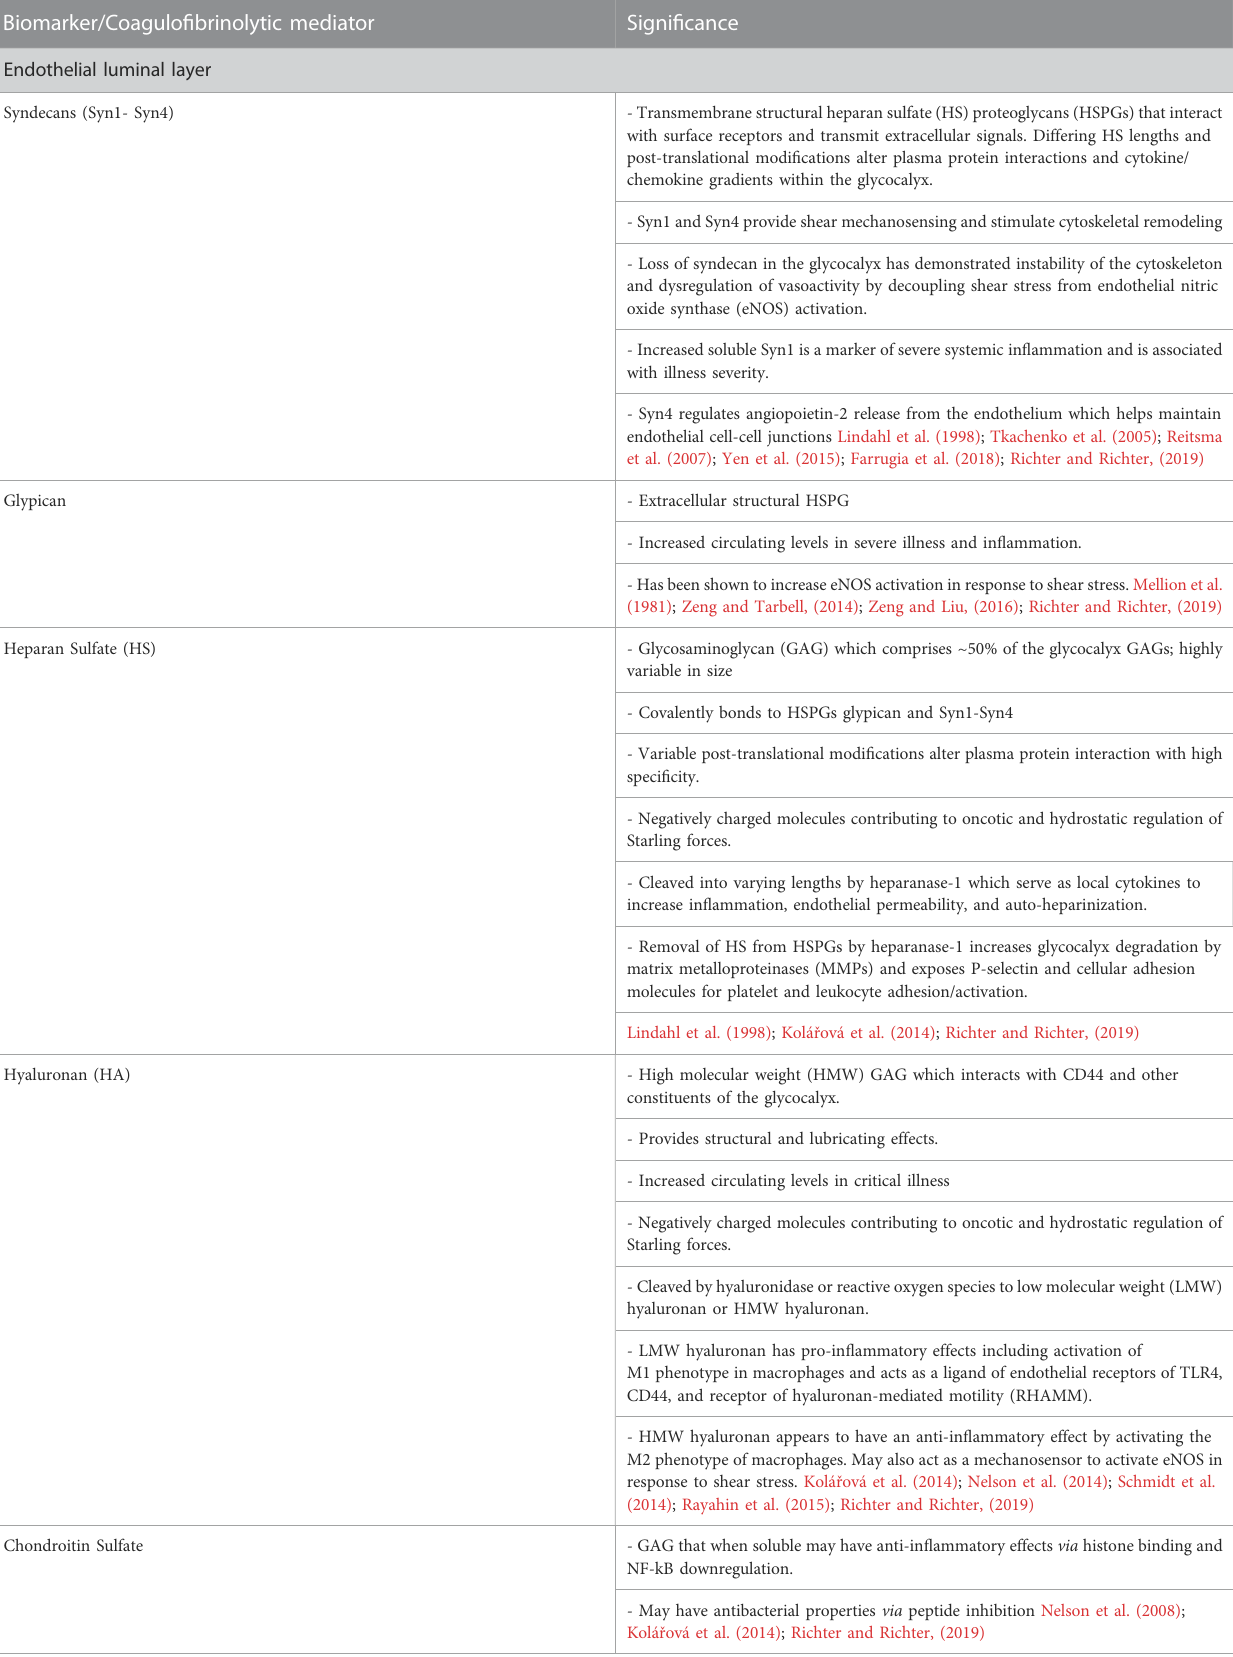
TABLE 1 Endothelial Biomarkers and Coagulo fi brinolytic Mediators and their Physiologic, Pathophysiologic, and Clinical Signi fi cance. Biomarker/Coagulo fi brinolytic